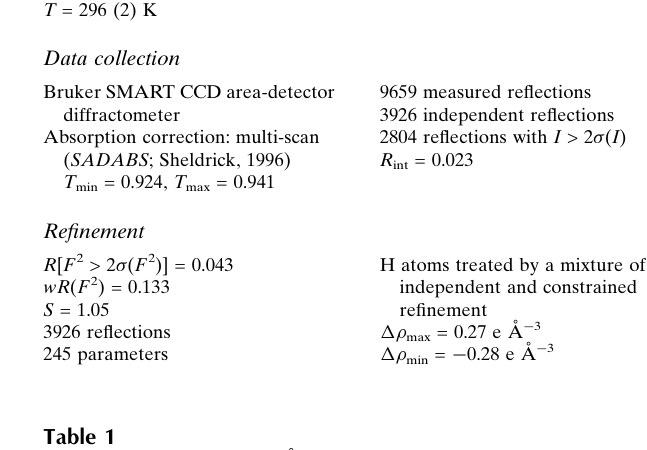
Hydrogen-bond geometry (A˚ , (cid:2)